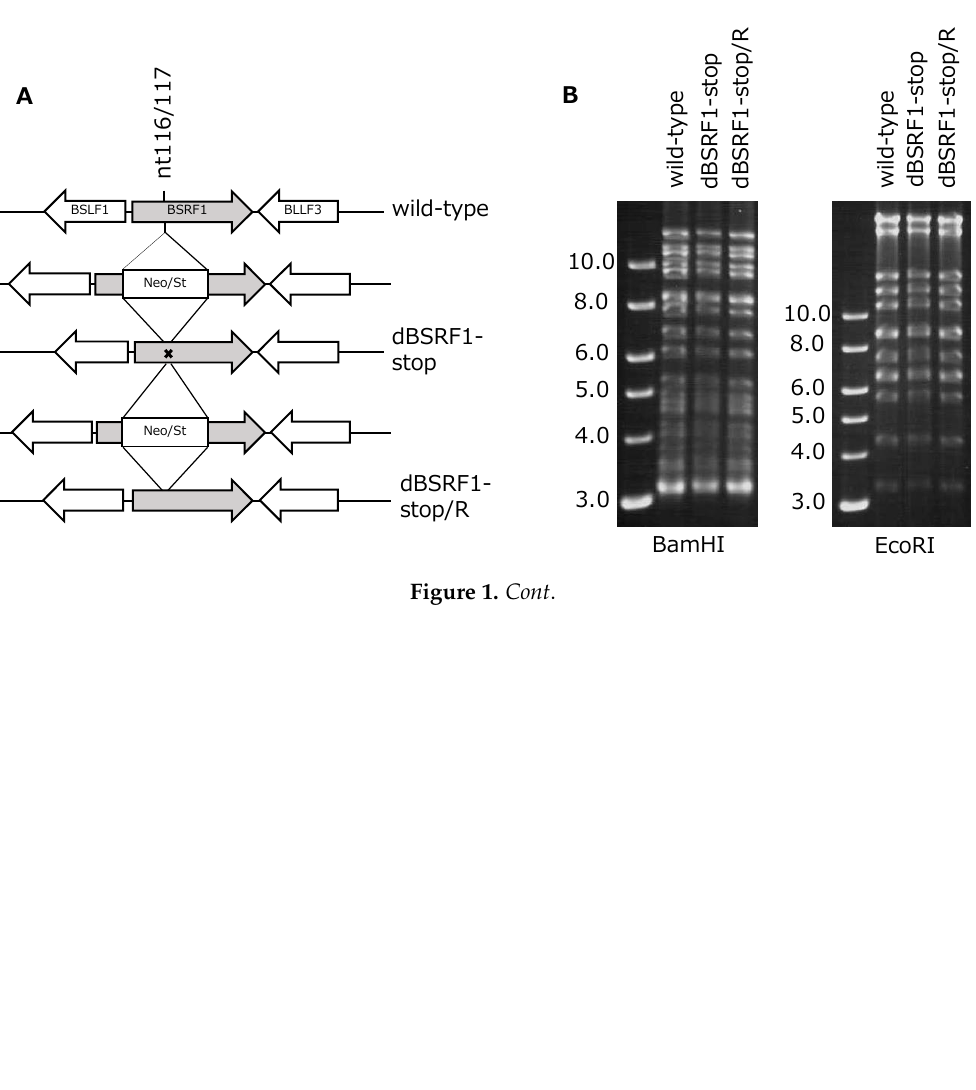
Figure 1. Construction of the Bam HI S rightward reading frame 1 (BSRF1) knockout (KO) mutant. ( A ) Schematic representation of the recombination of the Epstein–Barr virus (EBV)-bacterial artificial chromosome (BAC) genome using neomycin- and streptomycin-sensitivity genes in tandem (Neo/St). The insertion mutant was produced by inserting a Neo/St cassette at nucleotides 116 and 117 of the